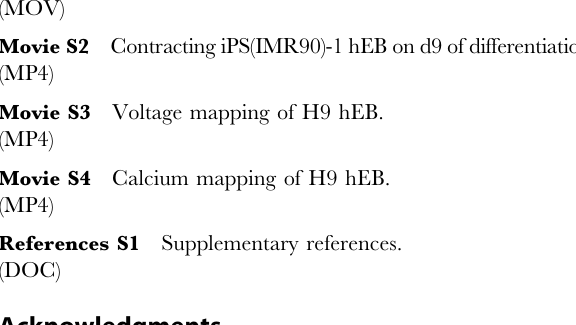
Figure S8 Demonstration of cardiomyocyte drug responsiveness and electrical coupling using optical mapping. ( A ) Time series of voltage maps demonstrates electrical coupling in an hESC-derived cardiomyocyte monolayer during 0.67 Hz pacing (pulse symbol indicates stimulus site, arrows indicate direction of propagation). A second, spontaneous activation site can seen on the upper right at 40 ms. b, Representative V m traces, time aligned by the stimulus timing, taken at site x in a. Isoproterenol and pinacidil shortened the action potential (363 6 137 ms control ( n = 73 recording sites) vs. 257 6 56 ms pinacidil ( n = 64) vs. 262 6 107 ms isoproterenol ( n = 94), mean 6 s.d.). ( B ) Electrical coupling between two hEB